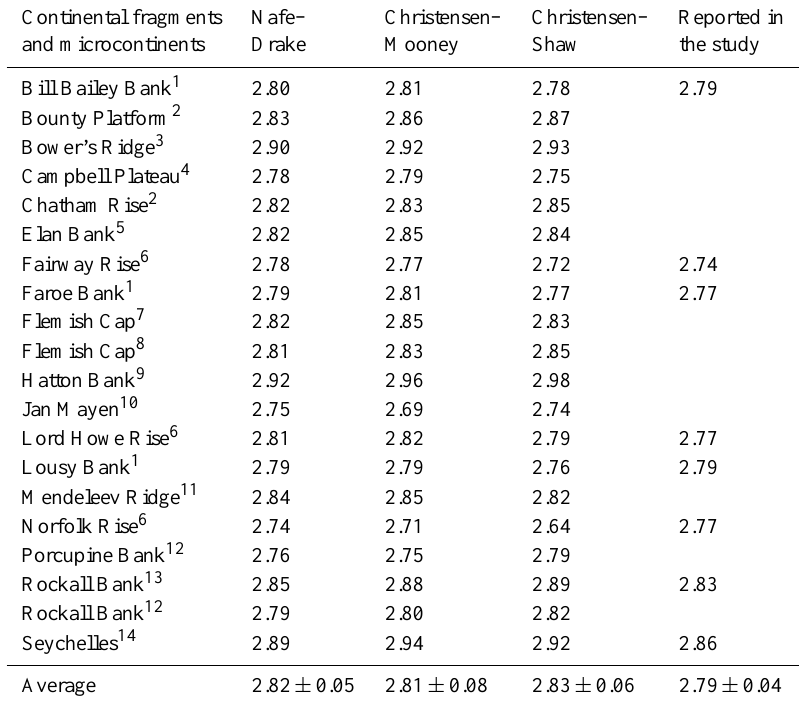
Table 6. Bulk densities (gcm − 3 ) of continental fragments and microcontinents determined from seismic velocities using various velocity– density curves. Bulk densities are also reported from studies where the authors combined gravity and seismic data to determine crustal density. References are (1) Funck et al. (2008), (2) Grobys et al. (2007), (3) Cooper et al. (1981), (4) Grobys et al. (2009), (5) Borissova et al. (2003), (6) Klingelhoefer et al. (2007), (7) Funck (2003), (8) Gerlings et al. (2011), (9) Fowler et al. (1989), (10) Breivik et al. (2012), (11) Lebedeva-Ivanova et al. (2006), (12) Morewood et al. (2005), (13) Vogt et al. (1998), and (14) Collier et al. (2009). Continental fragments Nafe– Christensen– Christensen– Reported in and microcontinents Drake Mooney Shaw the